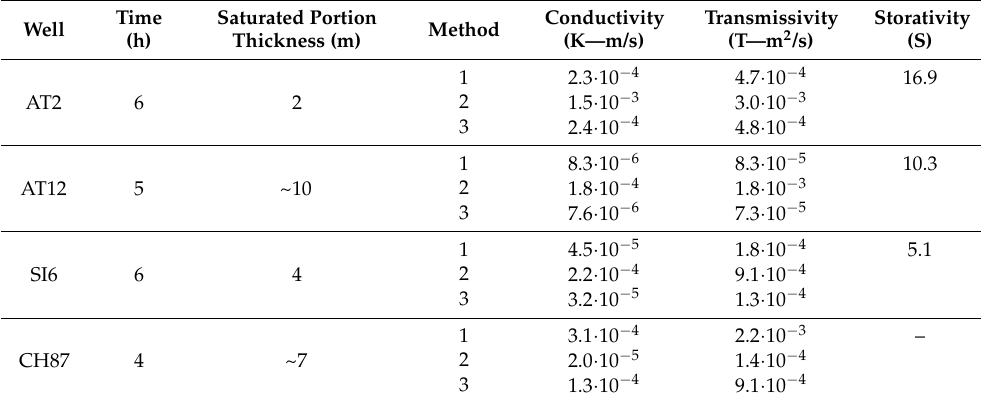
Table 8. Conductivity, transmissivity, and storativity obtained from the pumping test. Well